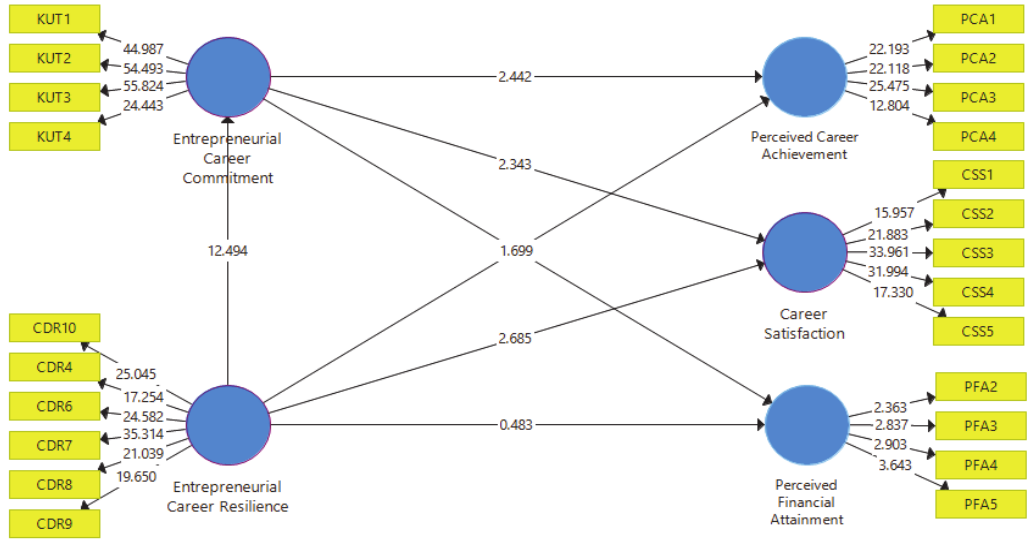
Fig. 3. Structural Model Assessment (Direct